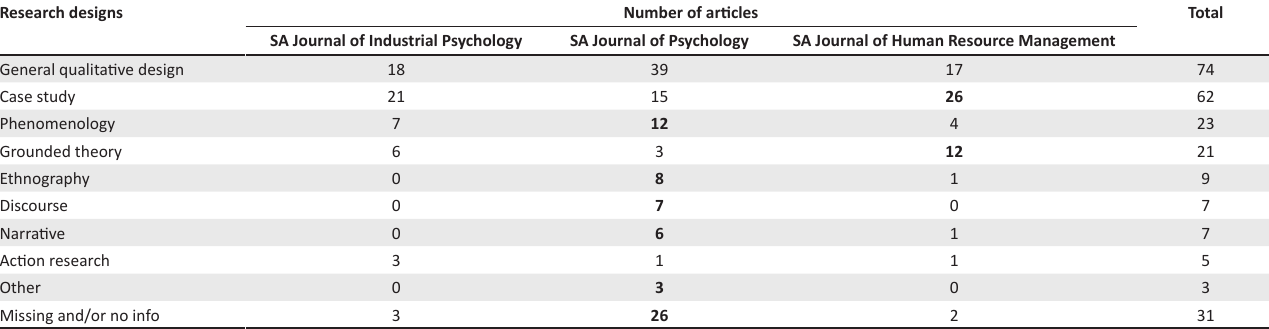
TABLE 3: Comparison of research designs indicated in the respective journals. Research designs